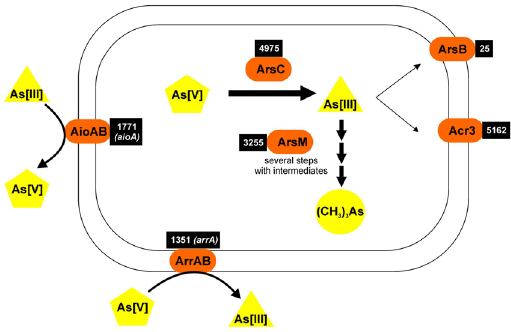
Figure 8. Summary of the arsenic metabolism in Socompa stromatolites. Abundances of the genes are shown in black boxes. arxA sequences are counted among the arrA , although they perform As[III]